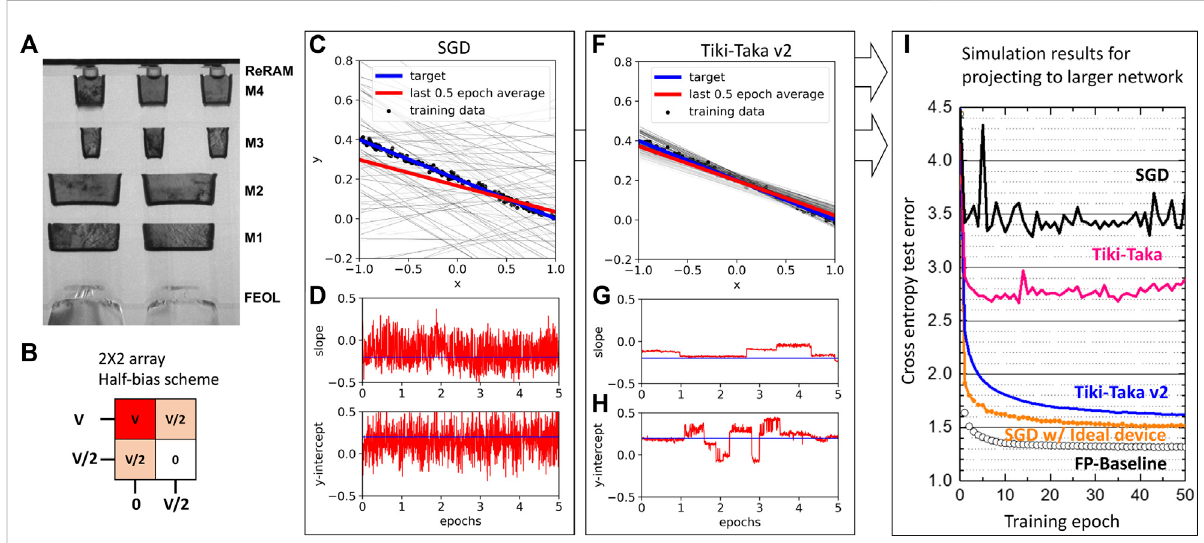
FIGURE 4 2×2arraypulse/disturbanceresponse. (A) Cross-sectionalTEMimageof1T1R devices. (B) Rowand column bias scheme forthehalf-selection scheme.Thegateisappliedtothe fi rstrow.Thefullbiasisappliedtothe(1,1)device,andthehalf-biasisappliedto(2,1)and(1,2)devices. (C – H) Two- variable fi tting results using the 2 × 2 array. The target slope ( − 0.25) and y-intercept ( − 0.25) are learned through (C) SGD algorithm, and the weight evolutions are depicted for the (D) slope and (E) y-intercept. (F) Same task is performed using the optimized “ Tiki-Taka ” algorithm. Corresponding w C values are plotted for the (G) slope and (H) y-intercept. (I) Simulation results using doubly stacked LSTM network trained on Leo Tolstoy ’ s War and Peace (WP) novel. Open circles are the cross entropy test error of the training results with the fl oating point (FP). Orange closed circles are SGD using the ideal (symmetric update, 1200 states, baseline 1x noise) device. Simulation results using baseline ReRAM stack characters (nonsymmetric update, 15 states, 260x noise). Simulation results using improved ReRAM stack characters (nonsymmetric update, 50 states, 96x noise). We observe the test error close to the FP using SGD for ideal symmetric device characteristics (rectangular symbols). However, the network exhibits the degradation of the test error when we introduce the nonsymmetric typical ReRAM characteristics (black lines). The improvement